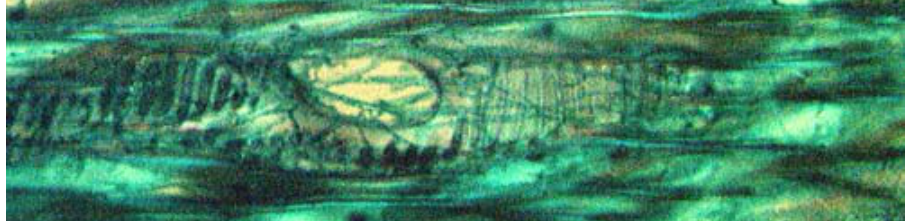
Fig. 5. Longitudinal section of xylem vessel with numerous hyphal strands. (cid:1)